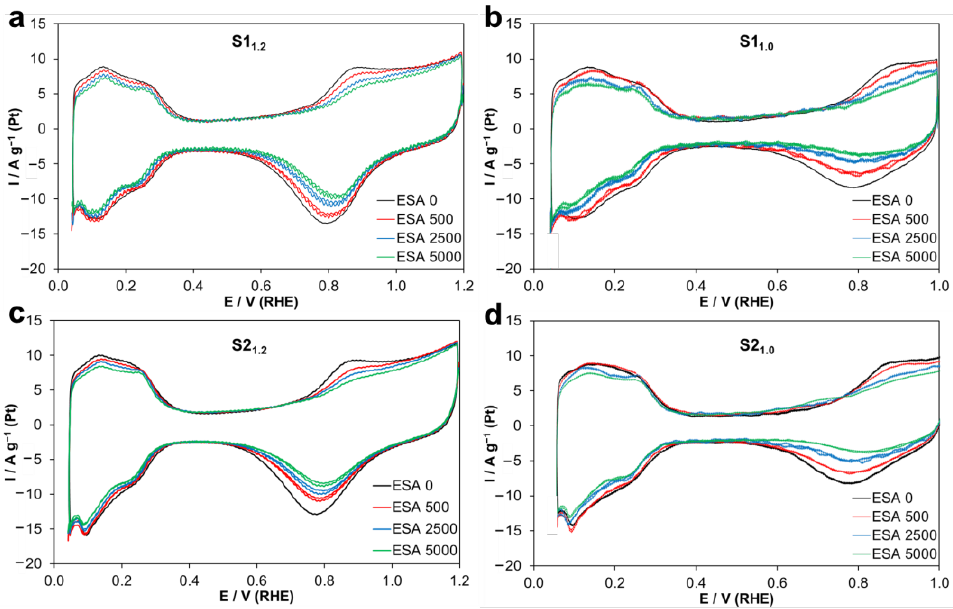
Figure 2. The CVs of the PtCu/C catalysts during different stages of the ADT. CVs are presented for materials S1 1.2 ( a ), S1 1.0 ( b ), S2 1.2 ( c ), and S2 1.0 ( d ).